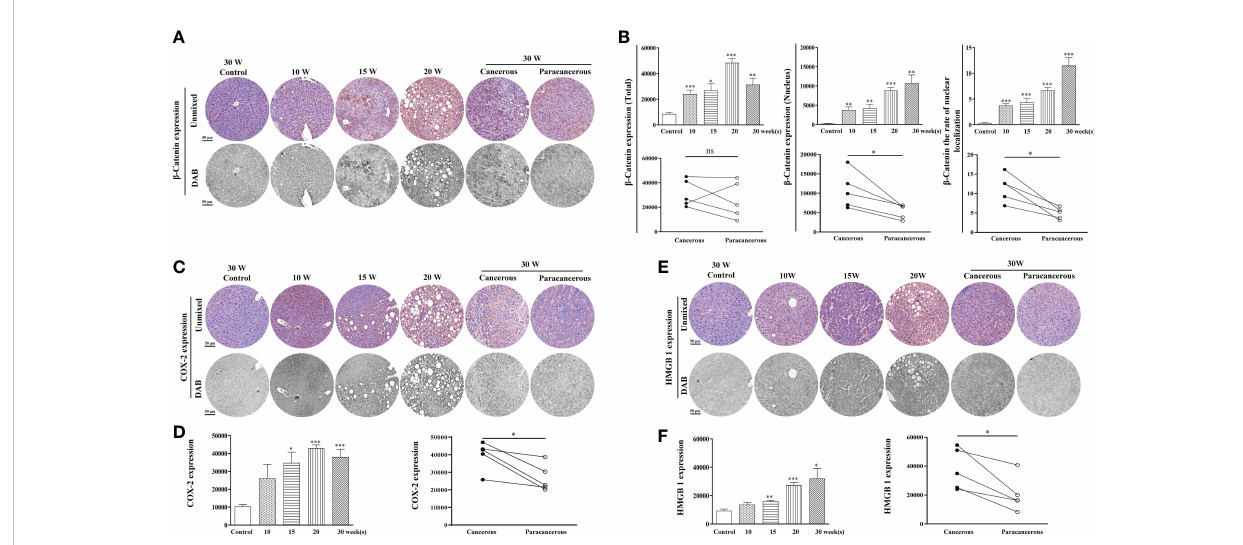
FIGURE 3 Immunohistochemical staining of b -catenin, COX-2, and HMGB1 proteins in mouse livers at different time points and their quantitative representative images. (A) Representative images of immunohistochemical staining of b -catenin in mouse livers during liver carcinogenesis. (B) Quantitative multispectral image of the b -catenin protein. (C) Representative images of immunohistochemical staining of COX-2 in mouse livers during liver carcinogenesis. (D) Quantitative multispectral image of the COX-2 protein. (E) Representative images of immunohistochemical staining of HMGB1 in mouse livers during liver carcinogenesis. (F) Quantitative multispectral image of the HMGB1 protein. The experimental data are expressed as the mean ± SEM. Compared to the control, * p < 0.05; ** p < 0.01; *** p < 0.001. Compared to paracancerous regions, * p < 0.05; ** p < 0.01. Scale bar, 50 µm. ns, not statistically.